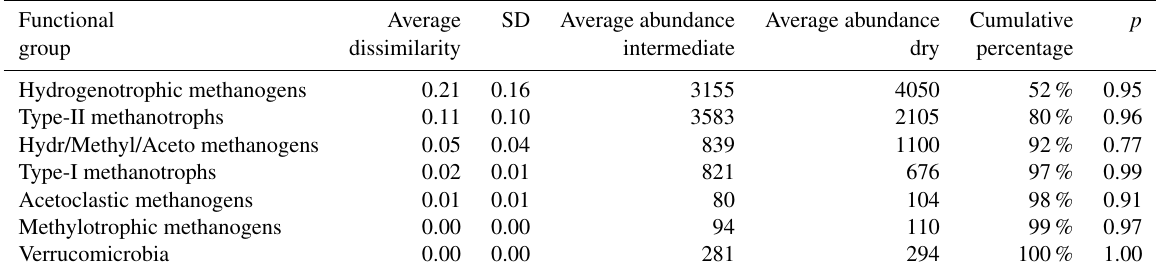
Table 4. Results of SIMPER analysis between intermediate ( n = 7) and dry ( n = 6) plots. Taxa are ranked according to their average contribution to dissimilarity between plots. Standard deviation (SD), average abundances, percentage of cumulative contribution, and the permutation p value (probability of obtaining a larger or equal average contribution in random permutation of the group factor) are also included.